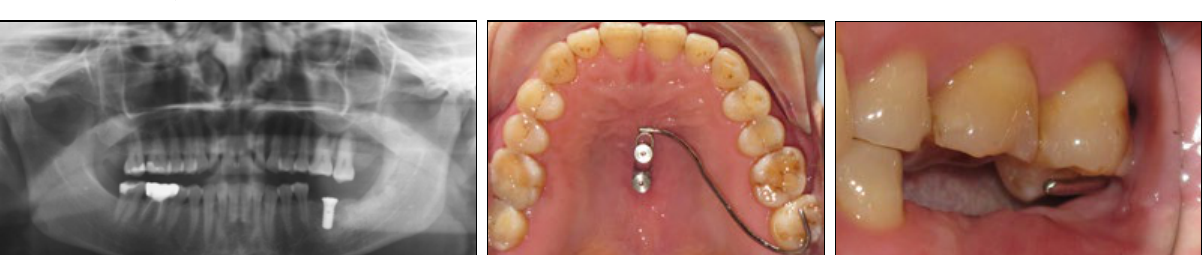
8Fig.7a Figure 7. Patient after prosthodontic restoration.